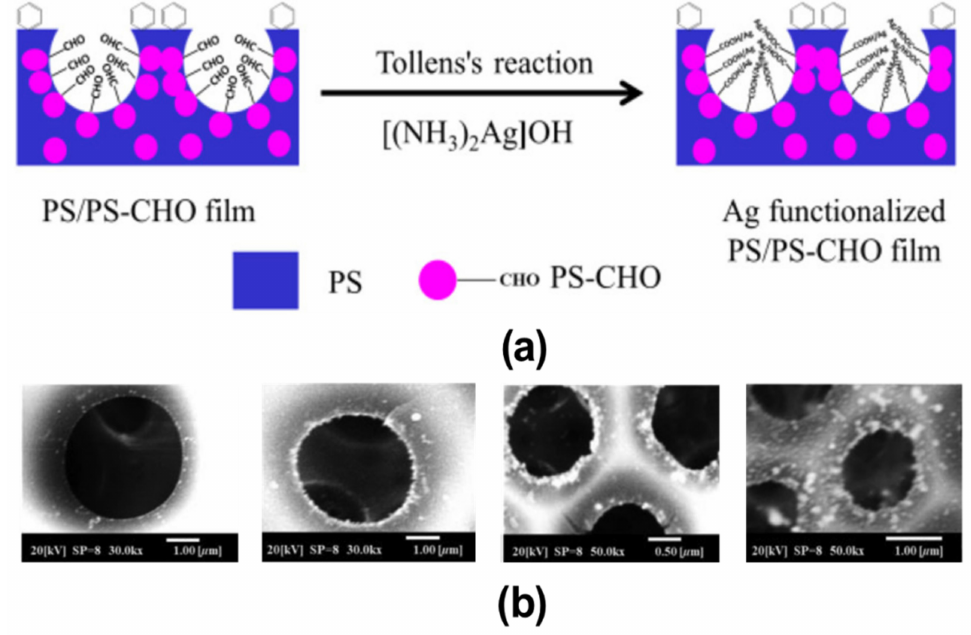
Figure 9. ( a ) Schematic representation of reaction mechanism of Tollens’s reagent with aldehyde group in HCP porous films fabricated using PS and PS-CHO blended solutions. ( b ) The typical SEM images of PS/PS-CHO HCP porous films with Ag functionalization after treating with Tollens’s reagent. Reprinted with permission from ref. [98]. Copyright 2018 Polymer